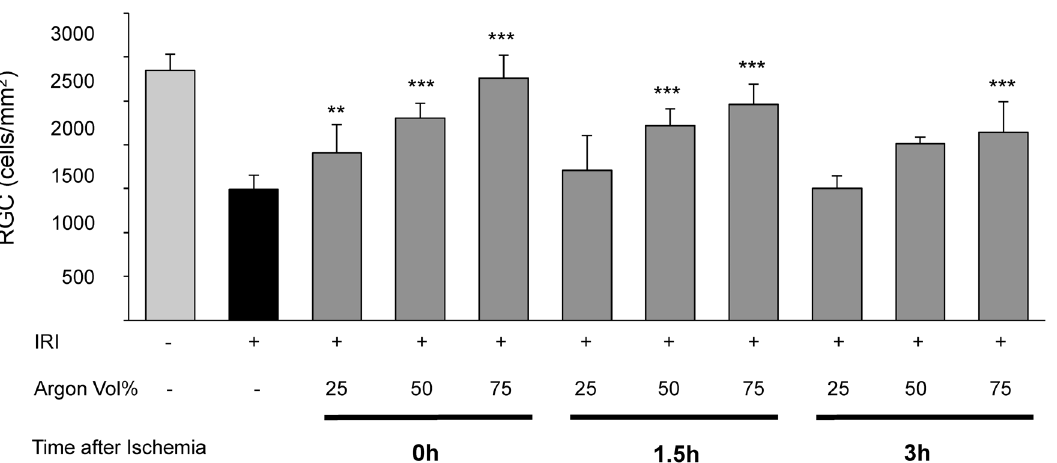
Fig. 1. Time- and dose-dependent influence of Argon inhalation on retinal ganglion cell count after ischemia reperfusion injury (IRI). Quantification of retinal ganglion cell density (cells/mm 2 , data are mean ¡ SD, n 5 8, *** 5 p , 0.001 IRI vs. IRI + Argon 75 Vol% at all time points, vs. IRI + Argon 50 Vol% at 1.5 h and 3 h delayed treatment, ** 5 p , 0.01 IRI vs. IRI + Argon 25 Vol% immediate treatment).